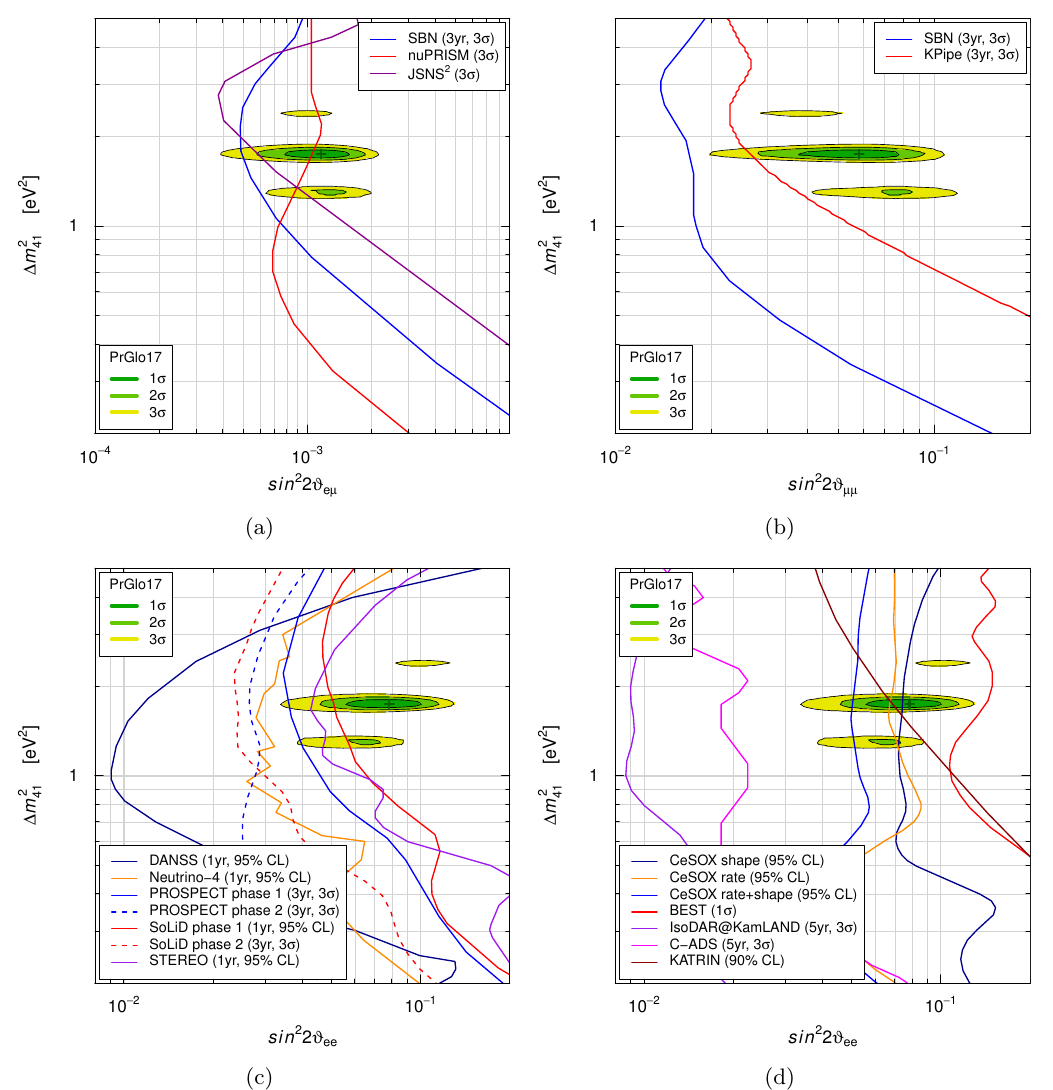
Figure 14 . Sensitivities of future experiments compared with the PrGlo17 allowed regions of (cid:12)gure